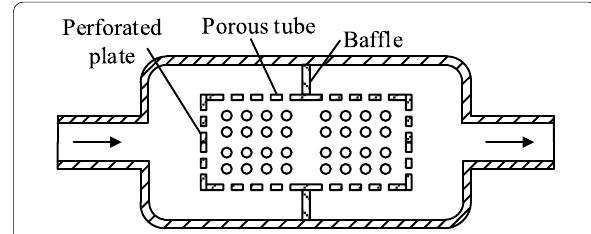
Figure 21 Composite porous tube pulsation attenuator